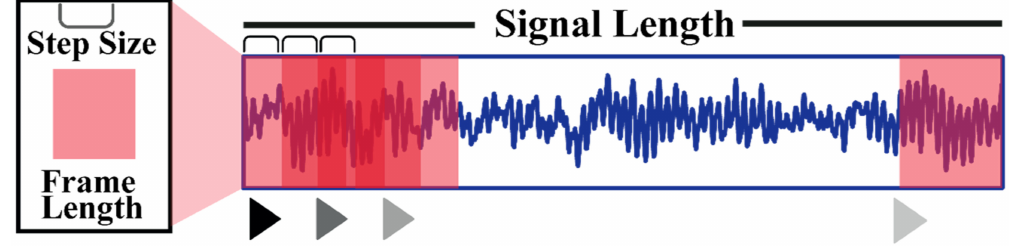
Figure 2. Adjustable sliding window